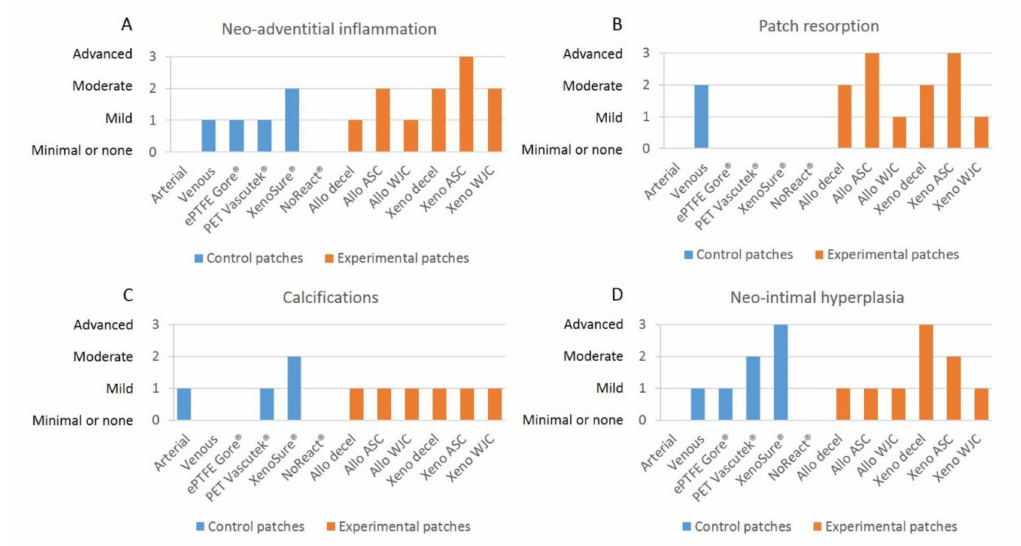
Figure 12. Grades of ( A ) neo-adventitial inflammation, ( B ) patch resorption, ( C ) calcifications, and ( D ) neo-intimal hyperplasia in control and experimental patches. We implanted six types of clinically used vascular patches as control grafts, namely two types of autologous patches: arterial autograft (Arterial) and venous autograft (Venous), two kinds of prosthetic patches: expanded polytetrafluoroethylene (ePTFE, Propaten ® Gore ® ) and polyethylene terephthalate (PET, Vascutek ® ), and two types of bioprosthetic patches: bovine pericardium chemically stabilized with glutaraldehyde (XenoSure ® ) and detoxified porcine pericardium (NoReact ® BioIntegral ® ). We further implanted six types of experimental pericardial patches, namely decellularized porcine allograft and ovine xenograft patches (Allo-decel and Xeno-decel, respectively), allograft and xenograft patches recellularized with autologous adipose tissue-derived stromal cells (Allo-ASC and Xeno-ASC, respectively), and allograft and xenograft patches recellularized with Wharton’s jelly mesenchymal stem cells (Allo-WJC and Xeno-WJC,